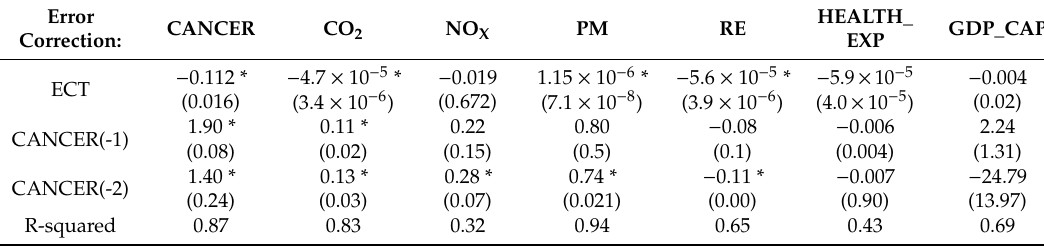
Table 6. Short-run dynamics based on a panel vector error correction model (VECM).